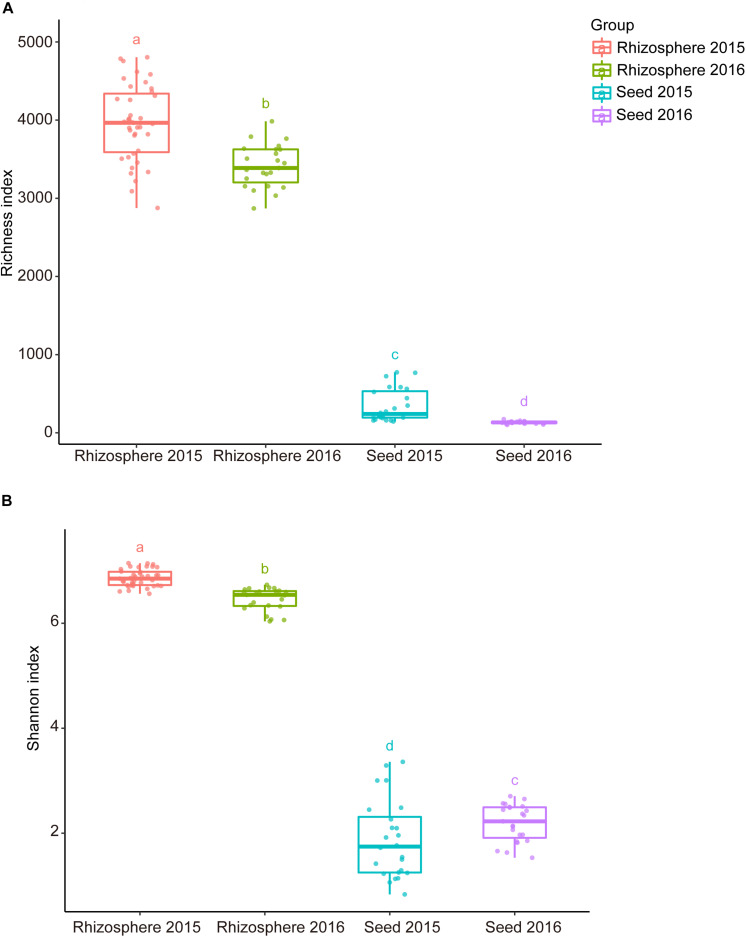
The alpha diversity indices of the seed and rhizosphere microbial communities. (A) Richness (number of OTUs); (B) Shannon-Wiener index. The lines inside boxes represent the median. The top and bottom whiskers indicate the 5th and 95th percentiles. Means were compared by one-way ANOVA, Tukey’s HSD and LSD-t comparisons. Different lowercase letters on top of the boxplots designate bacterial communities differed significantly in alpha-diversity (alpha = 0.05).